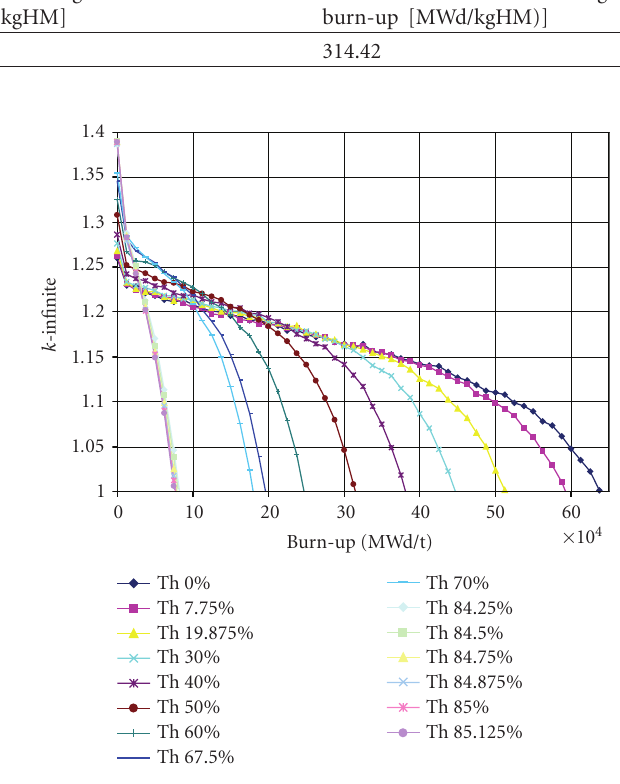
Figure 11: k -infinite variation as a function of burn-up (expressed in